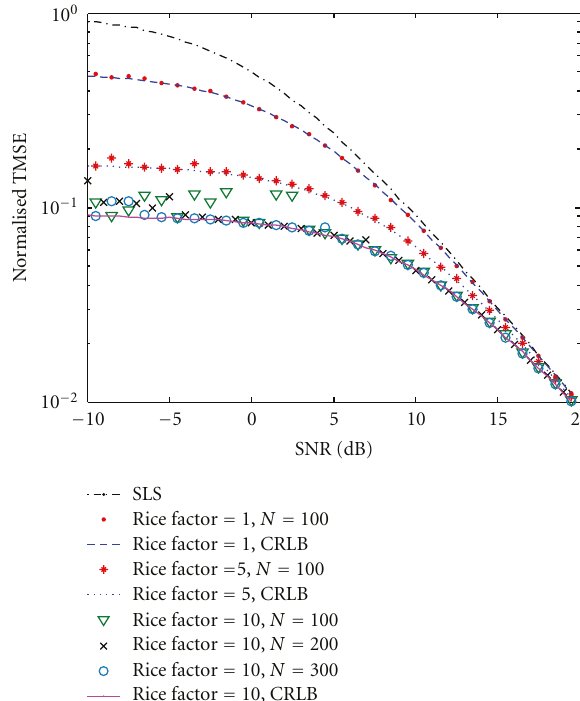
Figure 11: Normalized TMSE of the SSLS estimator by using the Rice factor estimation algorithm ( N T = N R = 2, L = 1, N P = 5).